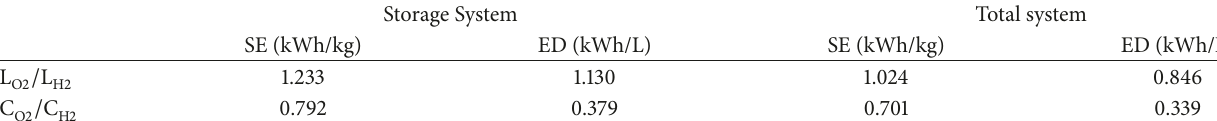
Table 8: SE and ED for storage and total fuel cell.